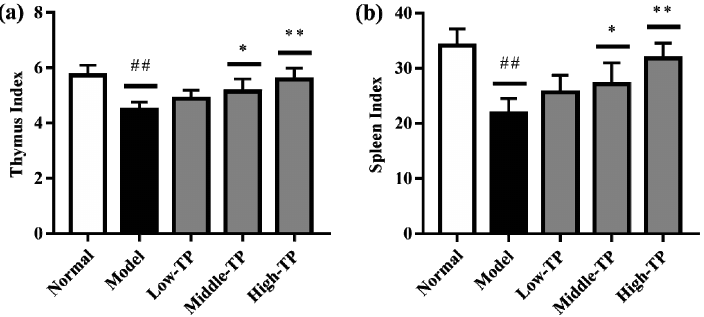
Figure 2. Effect of TP on immune organ indexes, ( a ) thymus index and ( b ) spleen index. ## p < 0.01, compared to Normal. * p < 0.05; ** p < 0.01, compared to Model.